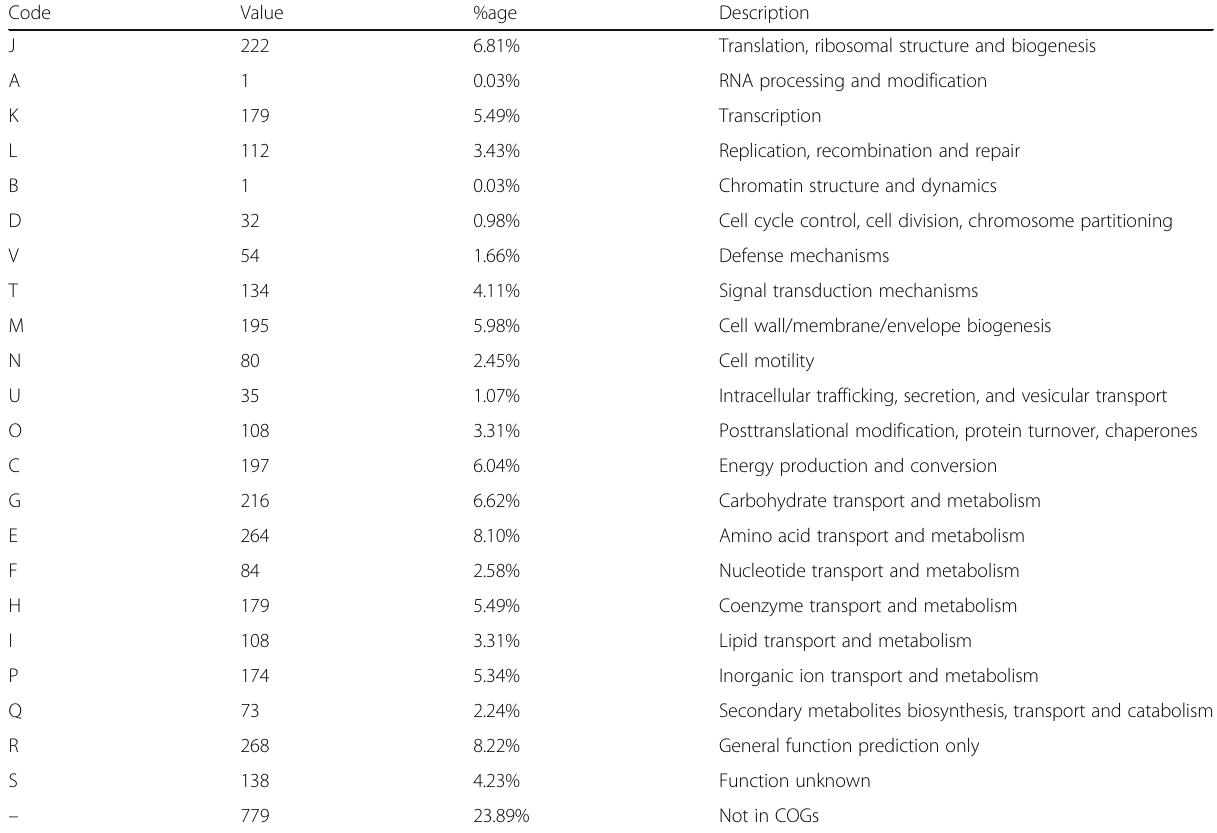
Table 4 Number of genes associated with general COGs functional